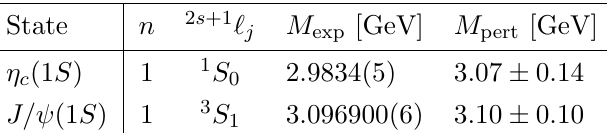
3 LO. The error is split by their di(cid:11)erent Table 4. Results for m c (cid:12)ts for di(cid:11)erent set of states at N contributions. All masses and errors are expressed in GeV. Columns 2 to 5 and 6 to 9 show the MSRn and MSRp schemes, respectively. Within each scheme block, the uncertainty is split in columns second to (cid:12)fth into experimental, perturbative and due to uncertainty in (cid:11) ( n f =5) s ( m Z ) and m b , respectively. For the n = 1 (cid:12)ts the error associated to the experimental uncertainty (that is, p the error coming from the (cid:12)t) is rescaled by the factor (cid:31) 2 . min